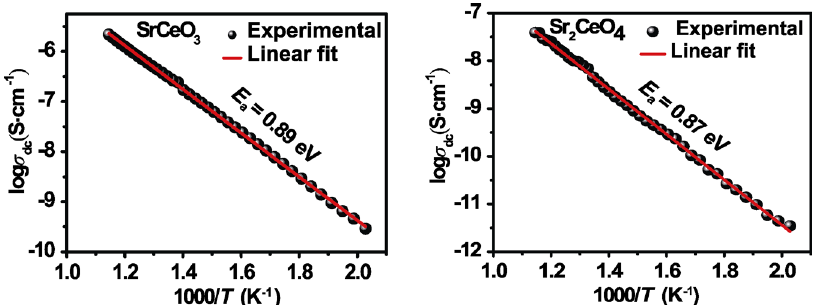
Fig. 10 Variation of logarithm of DC conductivity ( σ dc ) with inverse of